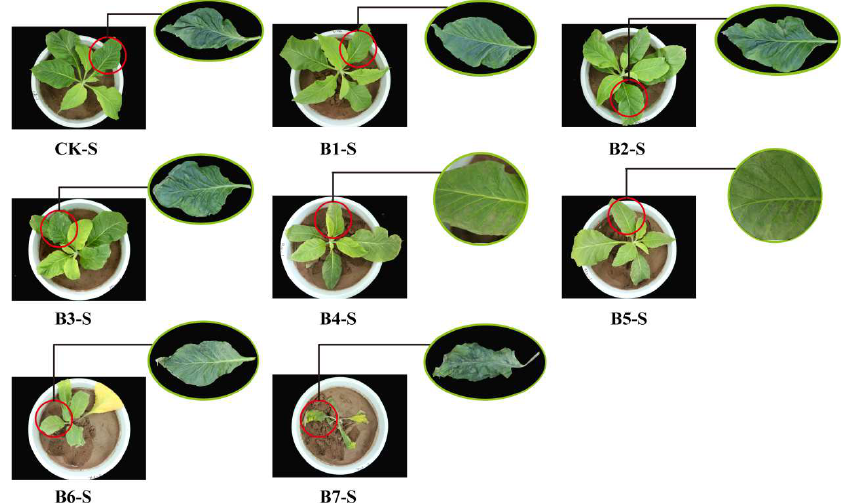
Figure 5. Growth statuses of flue-cured tobacco seedlings in pot experiment under different B concentrations. Note: 0.00 B kg·hm −2 (CK-S), 0.25 B kg·hm −2 (B1-S), 0.50 B kg·hm −2 (B2-S), 0.75 B kg·hm −2 (B3-S), 1.00 B kg·hm −2 (B4-S), 2.00 B kg·hm −2 (B5-S), 4.00 B kg·hm −2 (B6-S), 8.00 B kg·hm −2 (B7-S).